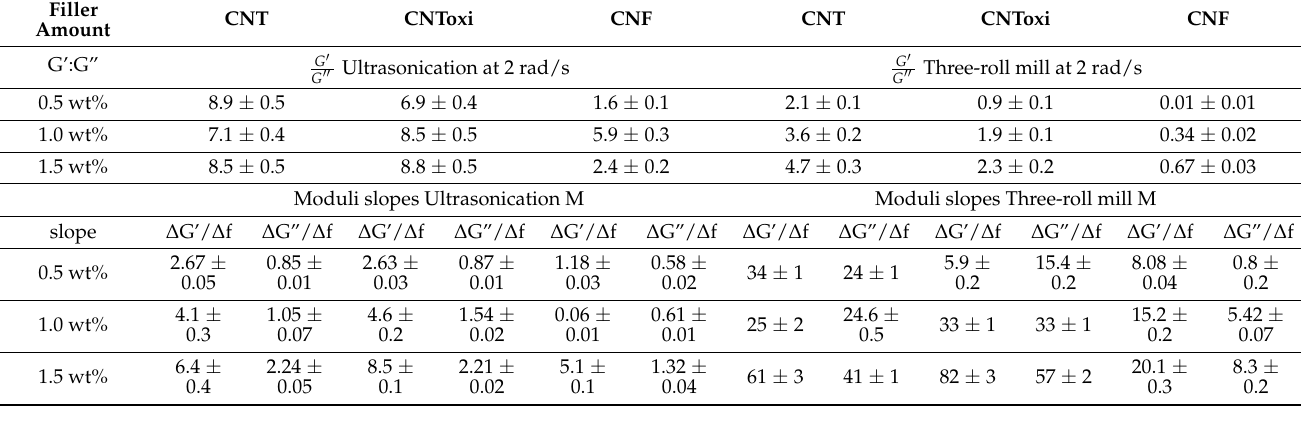
Table 5. Determination of the mean value and standard deviation of the G’:G” ratio and the slopes of G’ and G” over the whole measurement, which represents an estimation of the long-term stability of the dispersion samples.